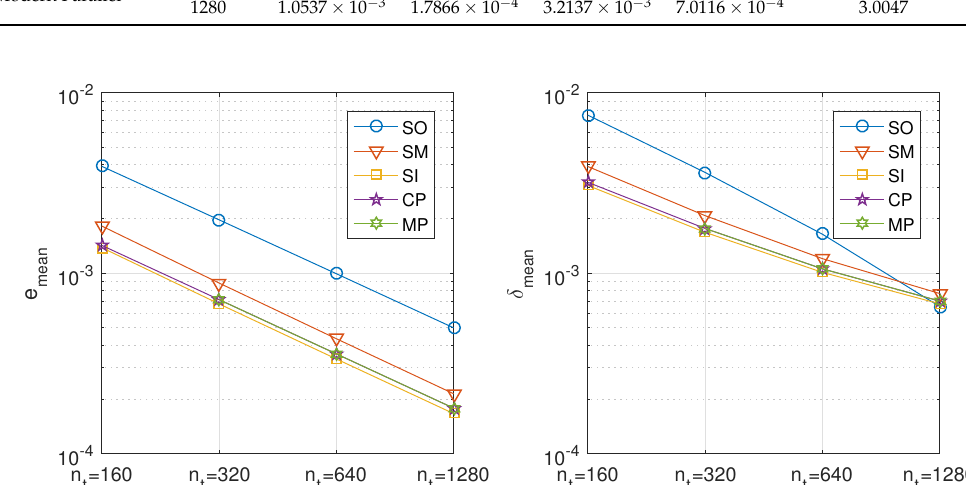
Figure 11. Mixed convection-diffusion and Burgers’ equation, convection-diffusion decomposition. Precision of the proposed methods: sequential iterative SI, classical parallel CP, and modern parallel MP, compared with the classical ones: sequential operator SO and Strang–Marchuk SM, for different number of time